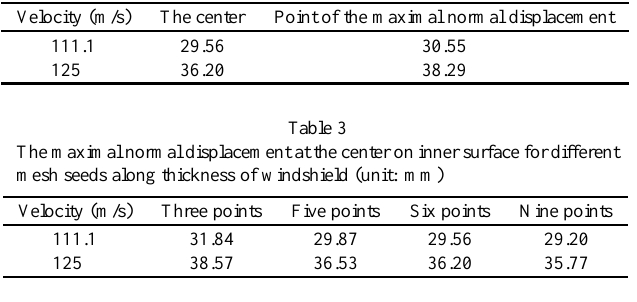
Table 4 The maximal normal displacement at the center on outer surface for different